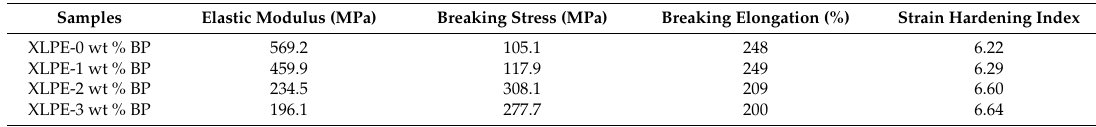
Table 2. Characteristic parameters of elongation